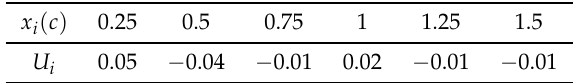
Table 1. Experimental points for polymer concrete